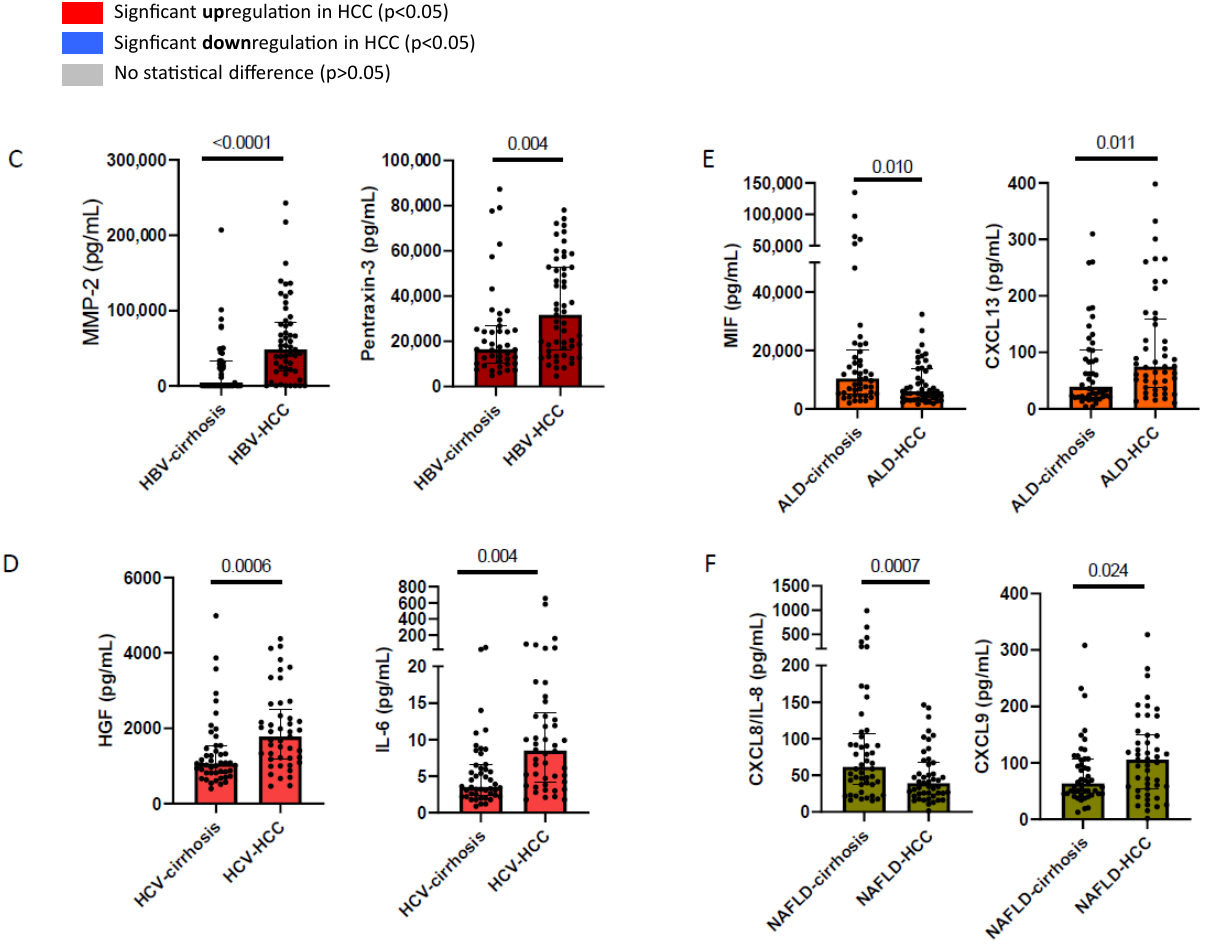
Figure 3. Bar plots show the number of significant Mann–Whitney U test for the comparison between HBV-HCC and HBV-cirrhosis, HCV-HCC and HCV-cirrhosis, ALD-HCC and ALD-cirrhosis,